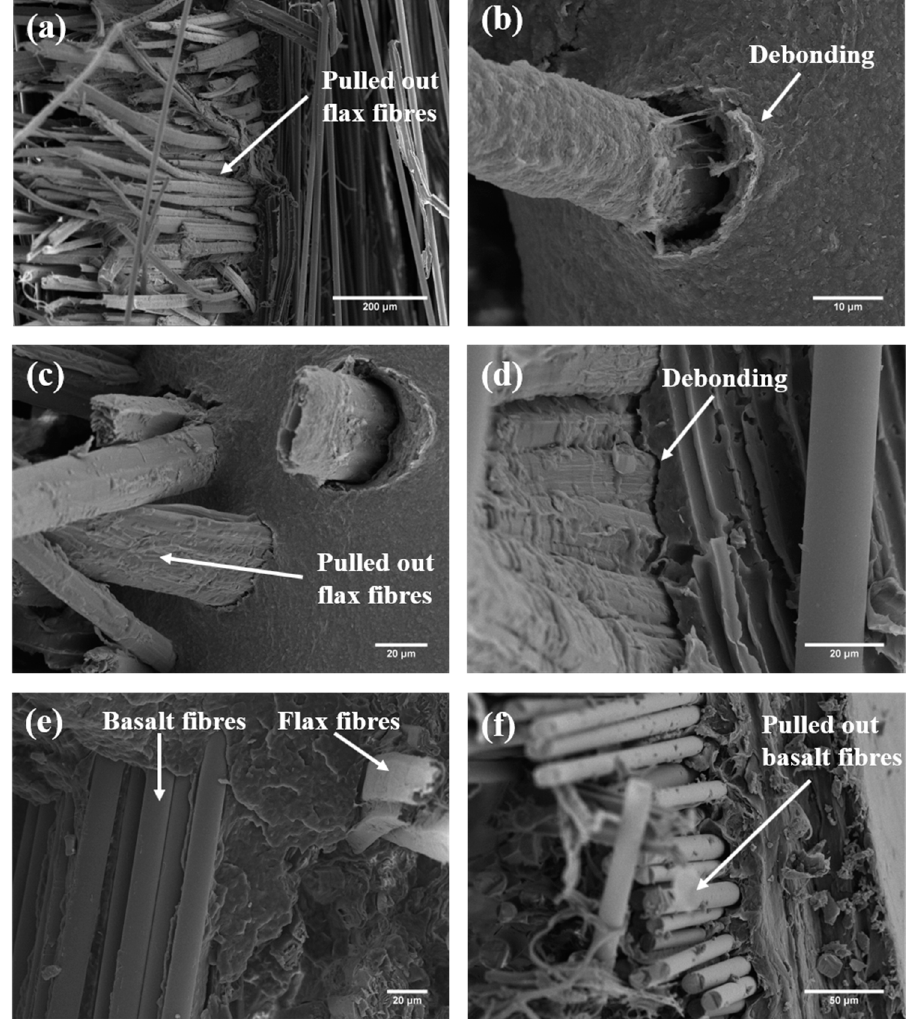
Figure 4. SEM micrographs of failed flexural H_PP specimens at different magnifications,